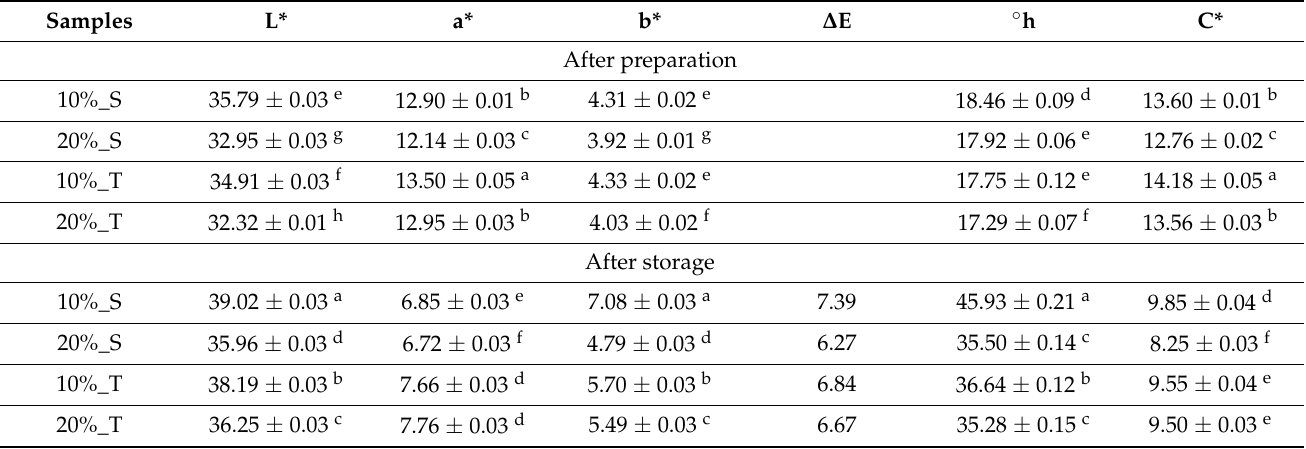
Within the column, means followed by different superscripts are significantly different at p ≤ 0.05 (ANOVA, Fisher’s LSD). S—citrus fiber/blackberry gels with sucrose; T—citrus fiber/blackberry gels with trehalose. ∆ E—change of color of citrus fiber/blackberry gels after storage in relation to gels after